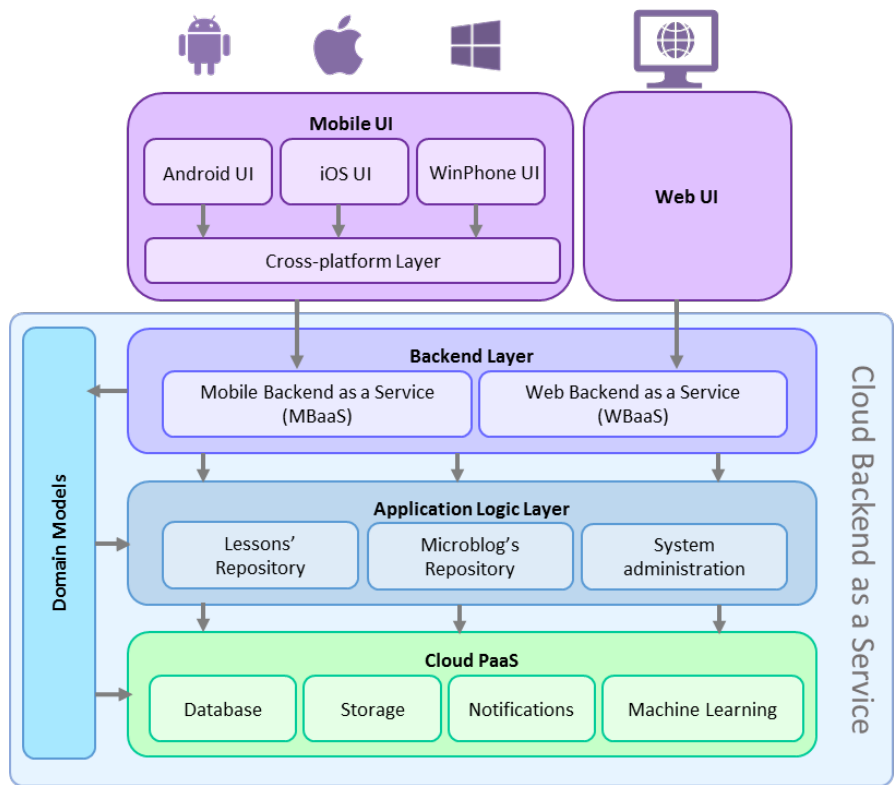
Figure 3. Proposed architecture for the MCC-based KM